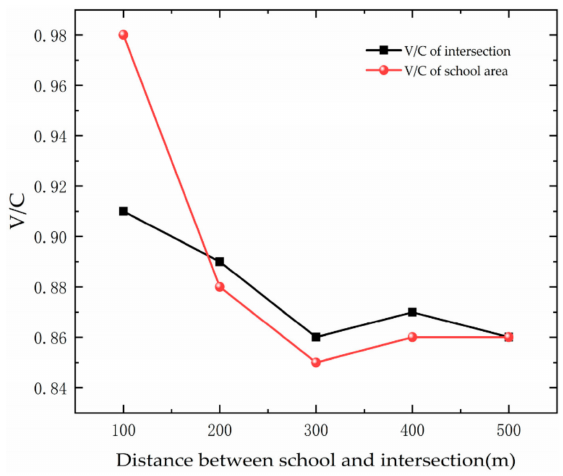
Figure 23. Variation trend of Saturation with DSI.